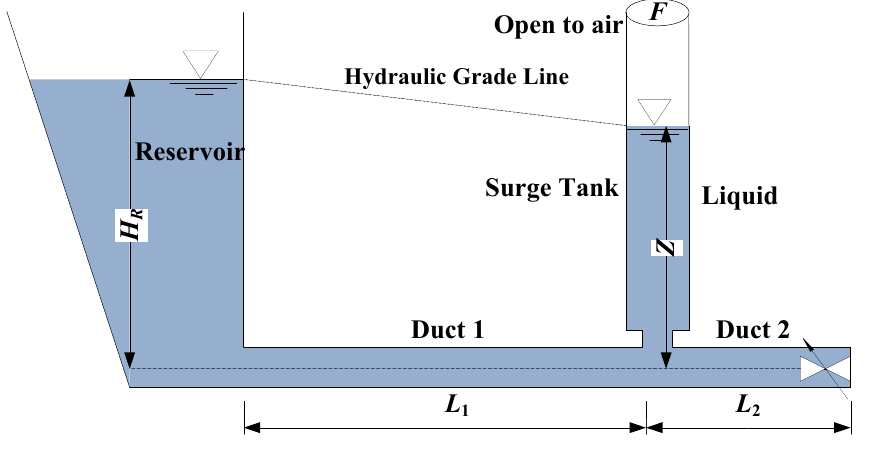
Figure 12. Reservoir-surge tank-valve